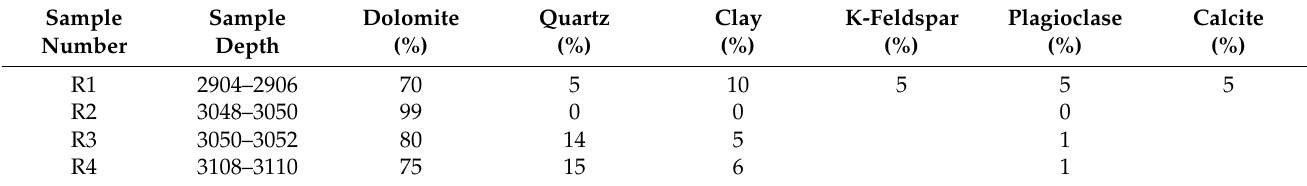
Table 2. Whole rock X-ray Diffraction analysis results for the core samples from the Xiong’an New Area.